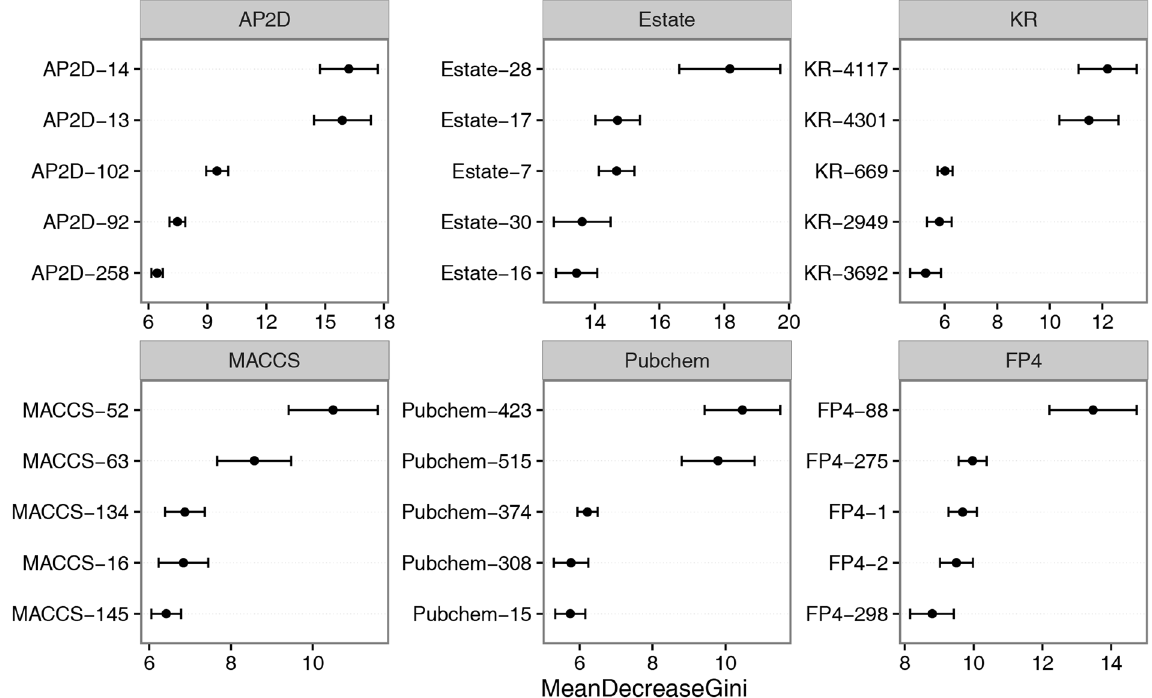
Figure 4. Feature importance results for top-five features from each RF model trained with Estate, MACCS, Pubchem, FP4, KR, and AP2D fingerprints. The MeanDecreaseGini values are represented as means and standard deviation.